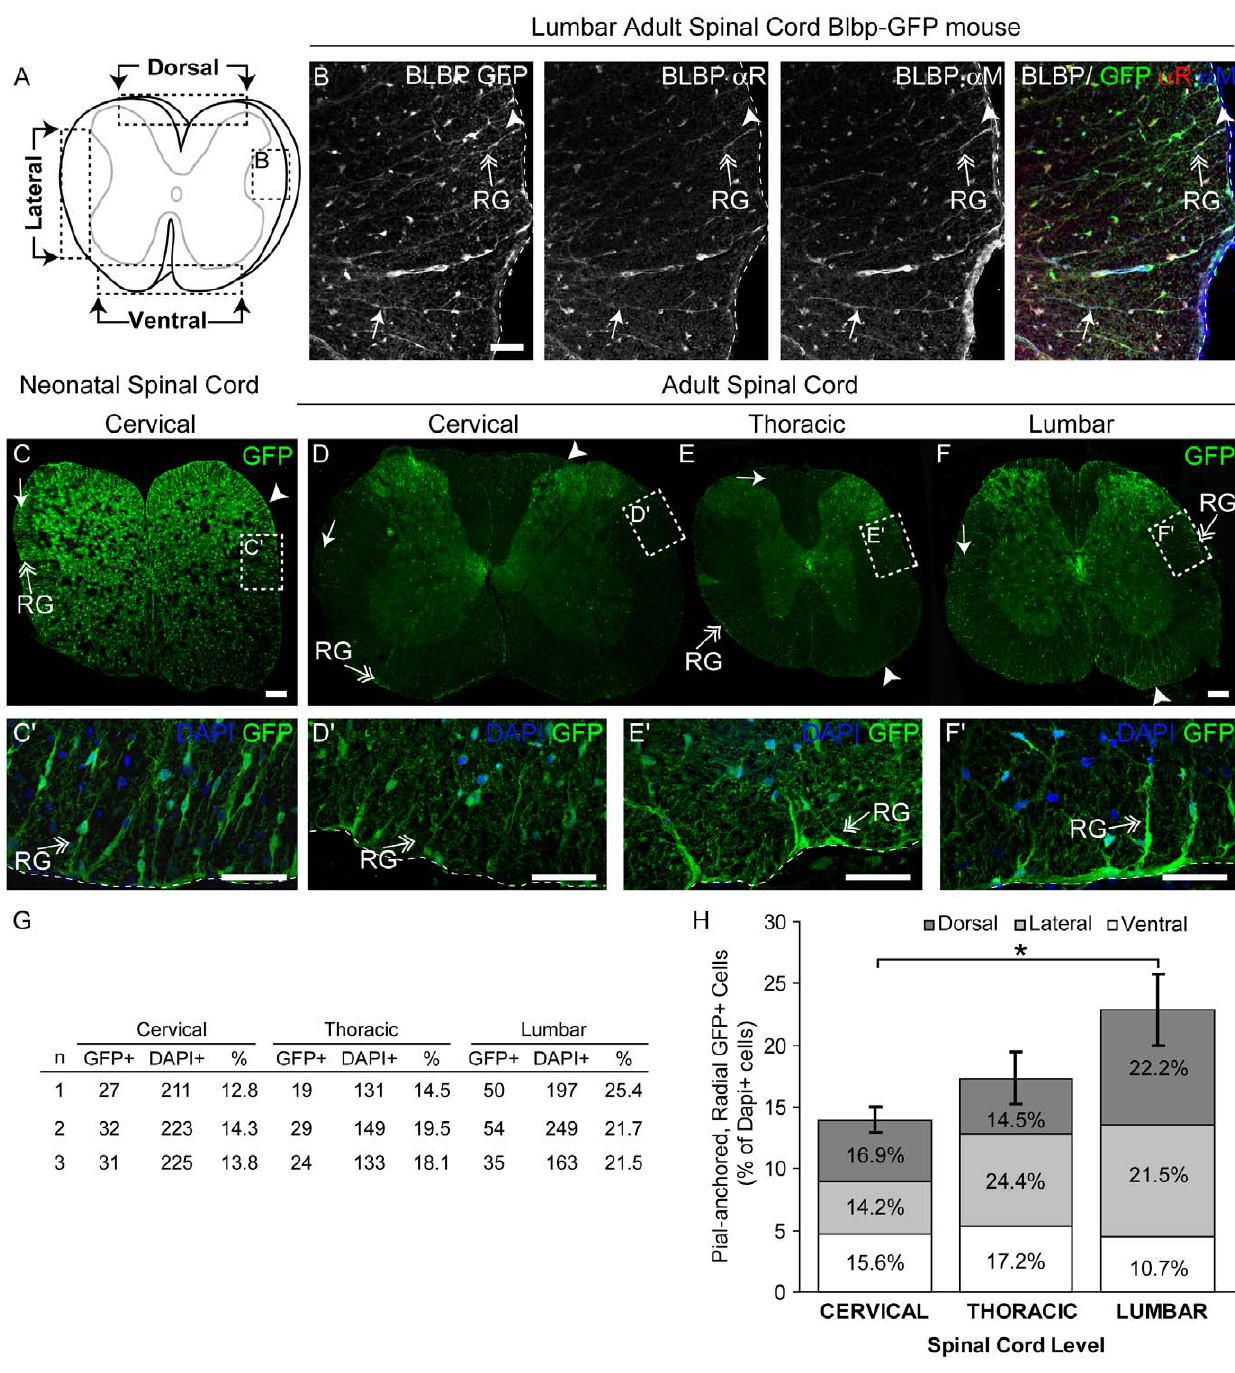
Figure 5. Radial Glia Are Distributed in an Increasing Cervical-to-Lumbar Gradient in the Spinal Cord of the Adult Fabp7-EGFP Reporter Mouse. (A) Schematic of SC cross-section detailing the position of the dorsal, lateral and ventral areas assayed in B–F, with arrowheads marking the anatomical boundaries for quantification. (B) Expression of eGFP was detectable, but enhanced by a GFP antibody, that confirms GFP co- localization with both rabbit and mouse anti-BLBP antibodies. (B–F) Confocal z-stack images of (C) neonatal (PND 5; cervical level) SC and (B, D–F) adult SC (P56; cervical, thoracic and lumbar levels) Fabp7-EGFP mice. (C) In the neonate, GFP + SCRG are abundant all around the SC. (D–F) In the adult SC GFP illuminates the cytoarchitecture of the processes and soma of pial RG (double arrow) and reveals that (G, H) GFP + SCRG significantly increase in frequency from cervical to thoracic and lumbar levels (p , 0.05), and also shift in their relative distribution in dorsal, lateral and ventral SC at different levels. Boxed areas outline magnified regions (C 9 , D 9 –F 9 ) of the z-stack. Arrowhead: soma; arrow: process; double arrow: SCRG; dotted line: marginal edge of SC. Scale bars: 50 m m.